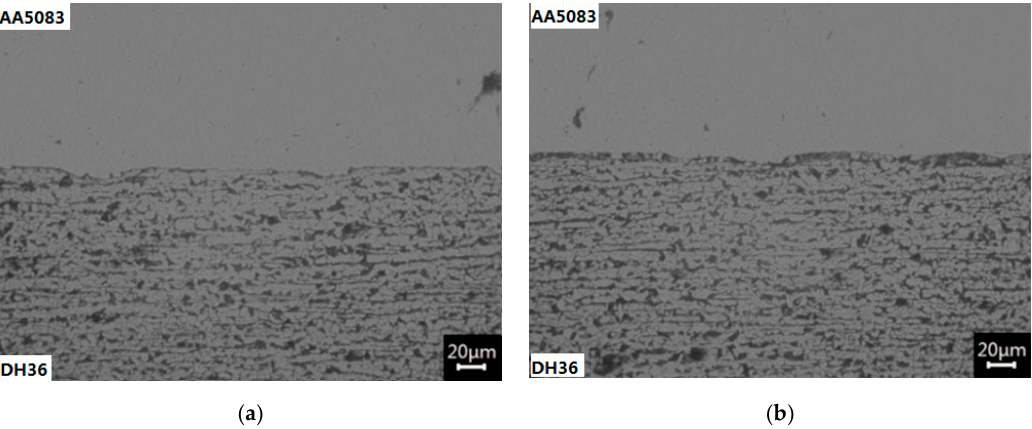
Figure 13. Deposition microstructures for specimen No. 4: ( a ) middle ( b ) retreating side.